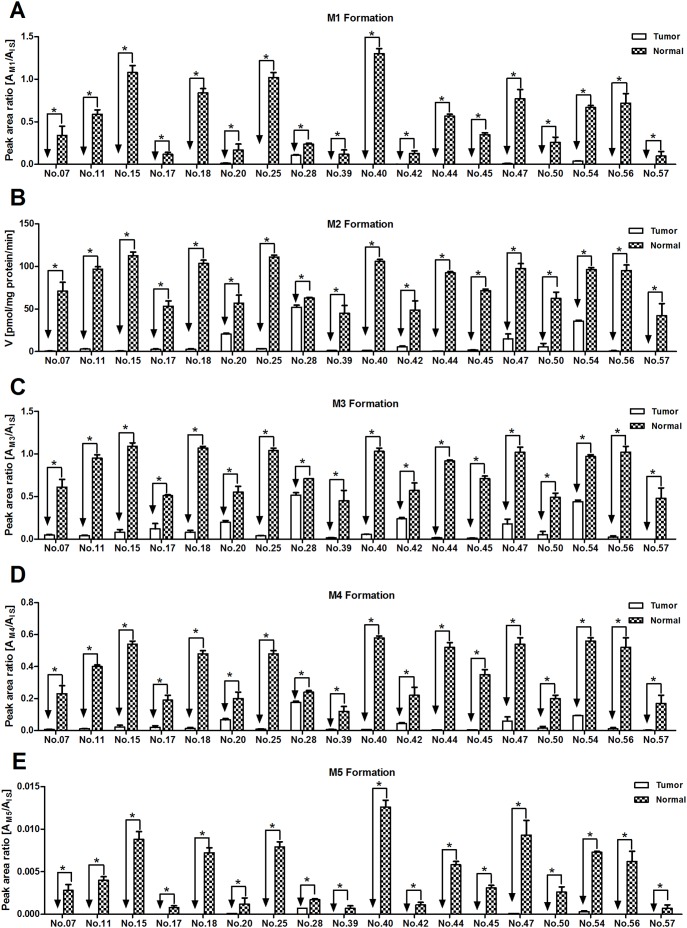
Inter-individual variability of sorafenib metabolism by CYP3A4 with 18 human liver microsomes samples (THLMs and NHLMs).Sorafenib (15 µM) was incubated with the microsomes obtained from different patients for 90 min at 37°C (the micorsome concentration was 0.4 mg/ml). The formation rate of M2 expressed as pmol/mg/min (mean ± SD), other metabolites rates (M1, M3, M4 and M5) expressed as peak area ratio (mean ± SD). All the experiments were performed in triplicate. Student’s T-test analysis was used for data analysis. “*” denotes statistical significance (P<0.05).